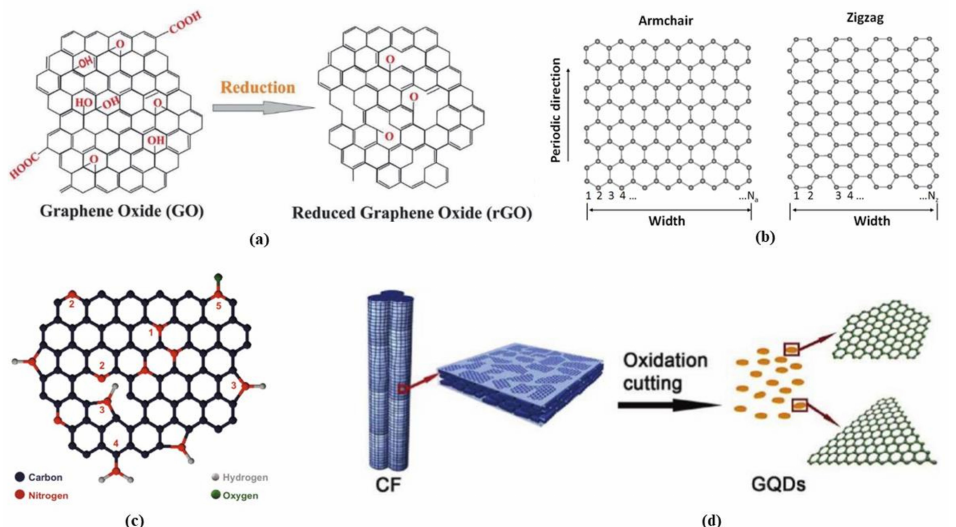
Figure 8. Structure of various graphene derivatives: ( a ) graphene and reduced graphene oxide (re- produced from [133] under common creative 4.0), ( b ) graphene nanoribbons (reproduced from [134] under common creative), ( c ) graphene nanowalls (reproduced from [135] under common creative 4.0), and ( d ) graphene quantum dots (reproduced from [136] with permission. Copyright 2012, American Chemical Society, Washington, WA,